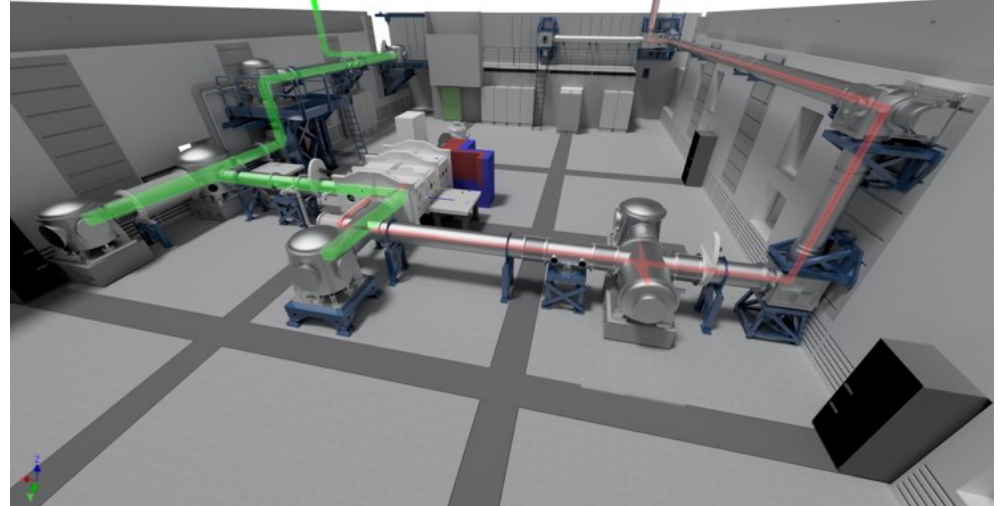
Figure 5. Rendering of the ELI Gammatron beamline located in experimental hall E2. The solid green beam is the PW-class HAPLS laser L3, and the solid red beam is the DUHA laser